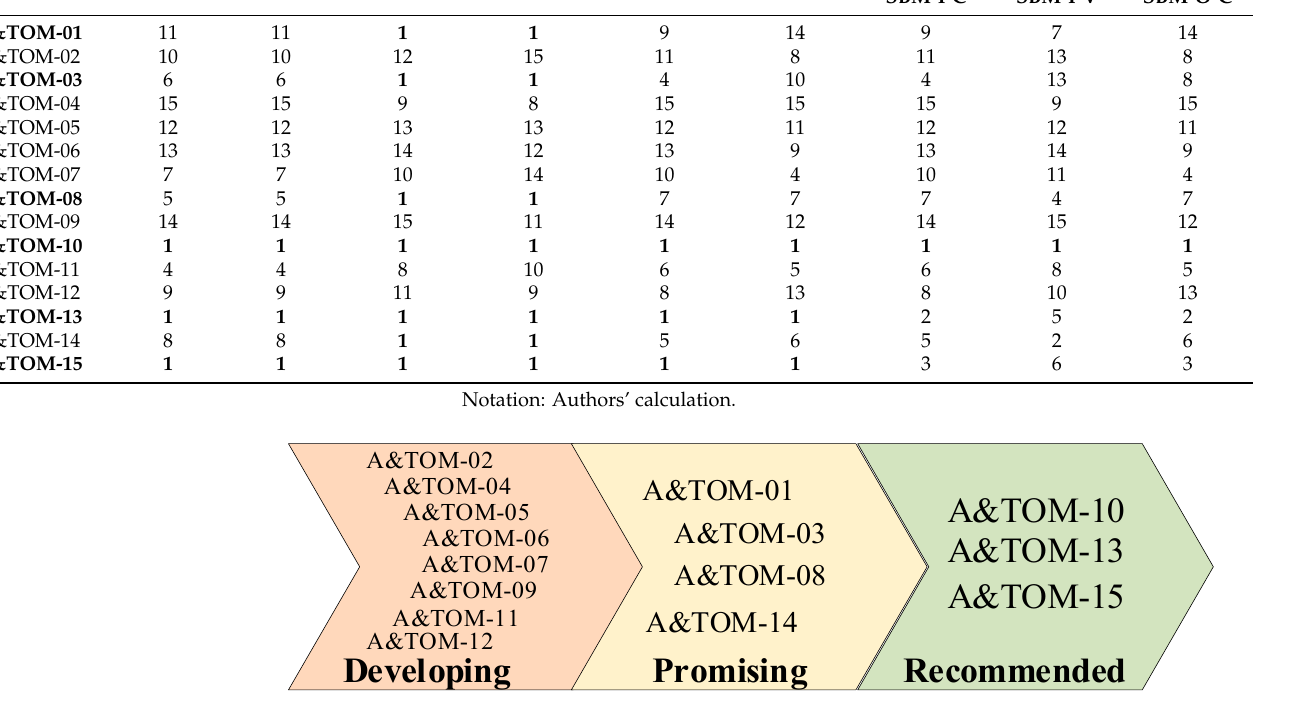
Figure 6. A&TOMs classification.